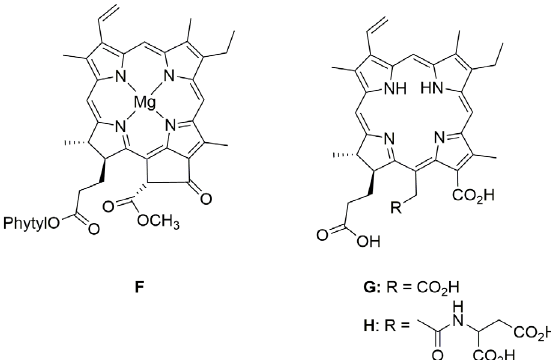
Figure 9 - Structures pf chlorophyll a ( F ), chlorin e6 ( G ) and MACE ( H ).